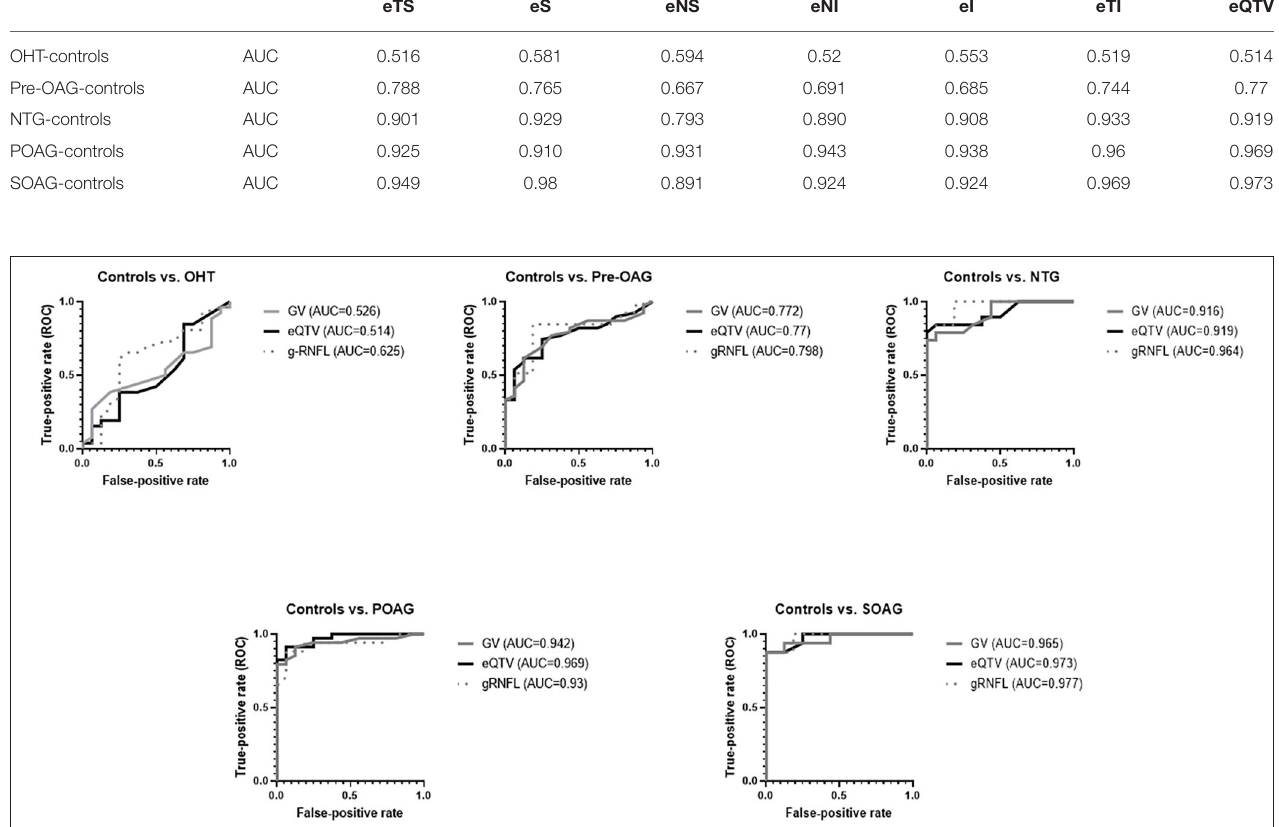
FIGURE 4 | ROC curves for GV, eQTV, and global RNFL (gRNFL) for each subgroup (OHT, Pre-OAG, NTG, POAG, SOAG vs. controls, respectively): In comparison to GV, eQTV yielded higher or similar AUCs.